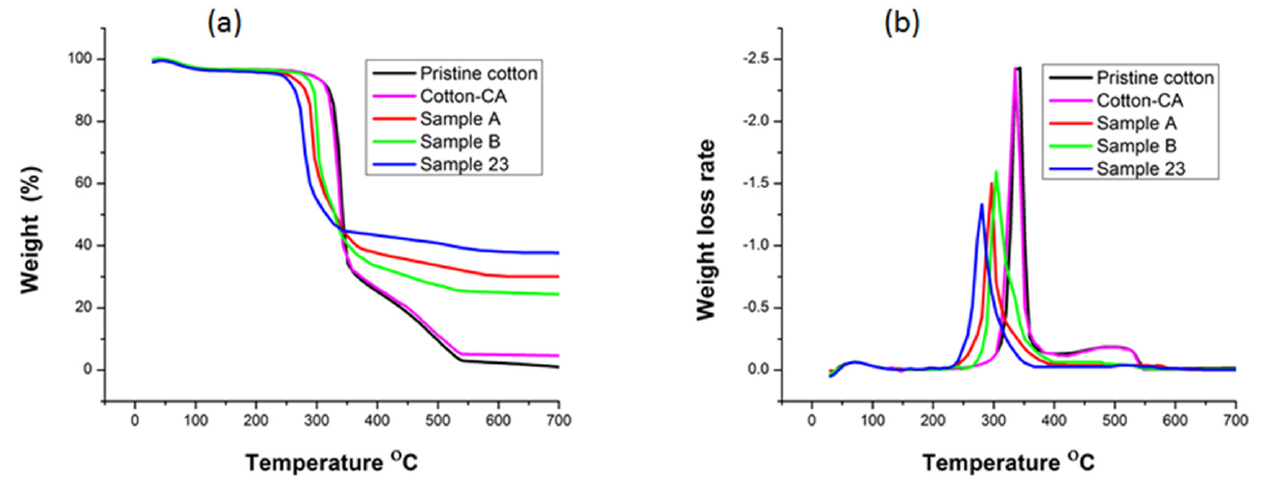
Figure 6. Thermo-oxidative behavior of ( a ) TGA curves and ( b ) dTG curves. Table 3. Thermal characteristics of pristine cotton and developed samples.